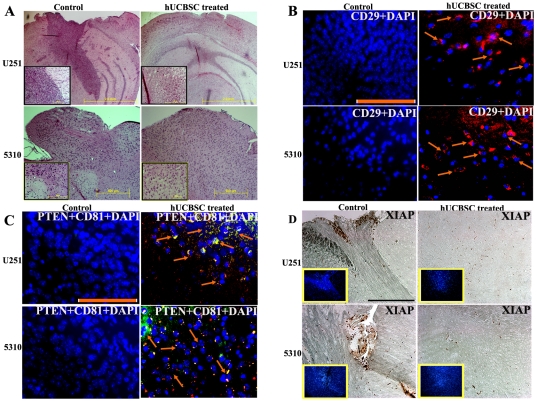
Inhibition of intracranial tumors by hUCBSC in vivo.(A) Nude mice with pre-established intracranial human glioma tumors (U251 or 5310) were treated with hUCBSC by intracranial injection (2.5×105). Fourteen days after hUCBSC administration, the brains were harvested, sectioned, and stained with Hematoxylin and Eosin (n≥3). Inset pictures show higher magnification at scale bar  = 100 µm. (B) Characterization of hUCBSC in tumor areas in nude mice brain sections: Fourteen days after hUCBSC administration, the brains were harvested, sectioned and immunoprobed with mesenchymal stem cell markers CD29 and CD81 using Alexa flour-594 secondary antibody. (n ≥ 3). Scale bar  = 100 µm. (C) Upregulation of PTEN in nude mice: Mice brain sections were immunoprobed with PTEN and CD81 using appropriate fluorescence-conjugated secondary antibodies. Secondary antibodies used for PTEN and CD81 were: goat anti-mouse Alexa flour-594 for PTEN and donkey anti-goat Alexa Fluor 488 for CD81, respectively. Scale bar  = 100 µm. (D) Downregulation of XIAP in mice: Mice brain sections were probed with XIAP antibody by DAB immunohistochemistry and counterstained with DAPI. Scale bar  = 100 µm. Inset pictures show DAPI. (n  = >3).